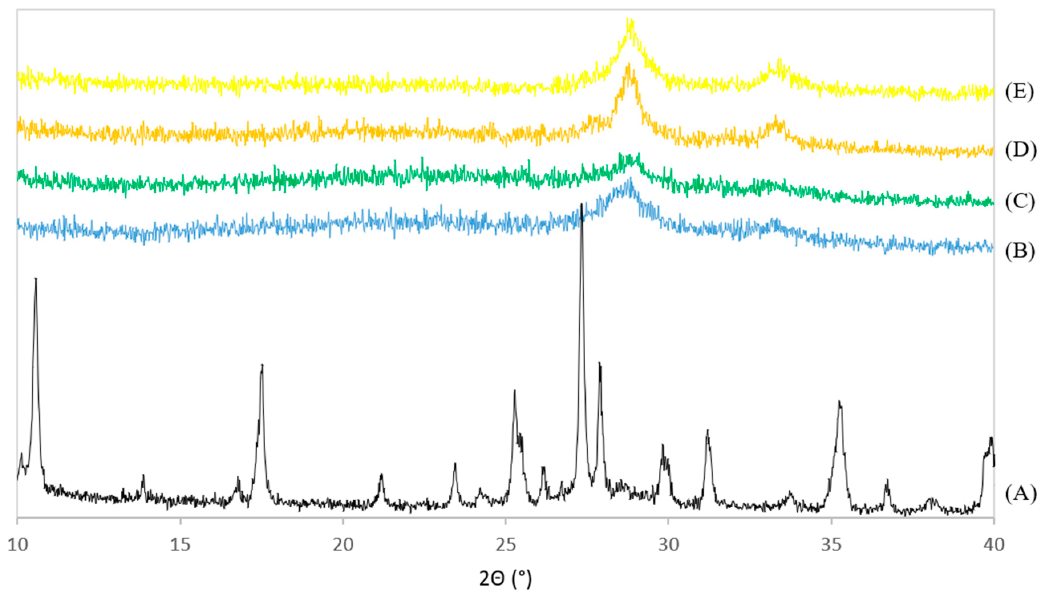
Figure 8. XRD patterns of the uncalcined Ce-LDH support from the scaled-up synthesis (A) and the calcined PdNi-Ce-LDH-200 (B), PdNi-Ce-LDH-400 (C), PdNi-Ce-LDH-600 (D) and PdNi-Ce-LDH-800 (E) catalysts.